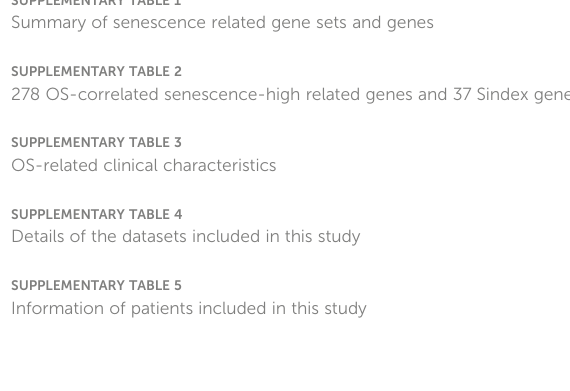
SUPPLEMENTARY FIGURE 2 Validation of the biological impacts of senescence. (A) GSEA enrichment showing upregulated pathways in CC2 versus CC1 in METABRIC. (B, C) Comparison of stromal (B) and immune (C) condition between CC1 and CC2 in METABRIC. (D, E) Comparison of tumor mutation burden (TMB) between CC1 and CC2 in TCGA (D) and METABRIC (E) . (F) Comparison of mutation frequencies between CC1 and CC2 in the METABRIC dataset. (G) The effect of wildtype P53 (P53WT) and mutant P53 (P53MUT) re-expression on senescence in terms of p16, p21, Rb, IL-6, IL-1 a , ICAM-1 and TGF- b mRNA content measure by RT-qPCR in the P53 truncated cell line MDA-MB-436. (H) The effect of wildtype P53 (P53WT) and mutant P53 (P53MUT) re- expression on senescence in terms of p16 and p21 mRNA content measure by RT-qPCR in the P53 knocked out cell line SW1990. SUPPLEMENTARY FIGURE 3 OncoPredict prediction of IC50 for different chemotherapeutic drugs in patients with BRCA from the METABRIC (A) and TCGA (B) dataset. SUPPLEMENTARY FIGURE 4 Correlation of Sindex with therapeutic responses in real-world data from I- SPY2 clinical trial by comparision of Sindex between responders and non- responders to (A) Neratinib, (B) MK2206, (C) Pertuzumab, (D) Ganitumab, (E)